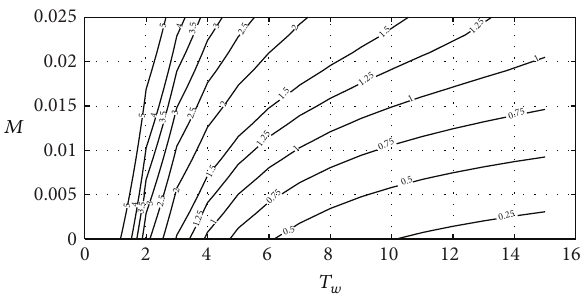
Figure 10: Relation between 𝑀 , 𝑇 𝑤 , and 𝑘 𝑖 .